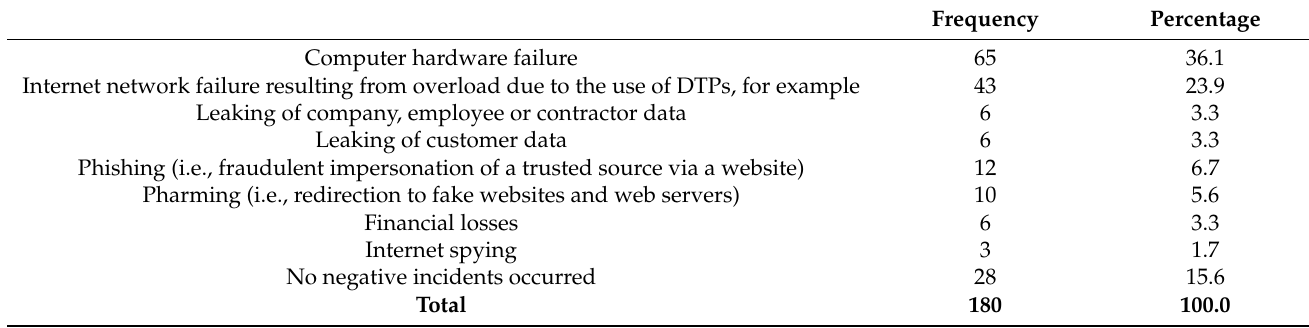
Table 4. Negative incidents and risks related to DTP